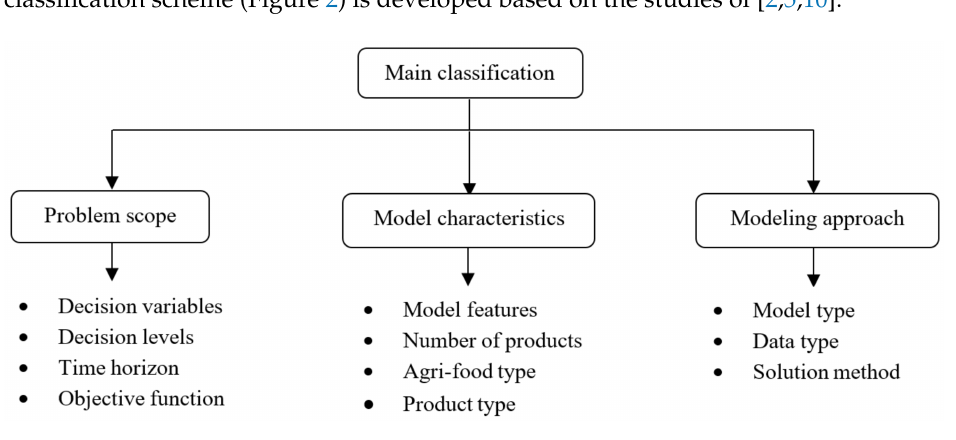
Figure 2. Classification